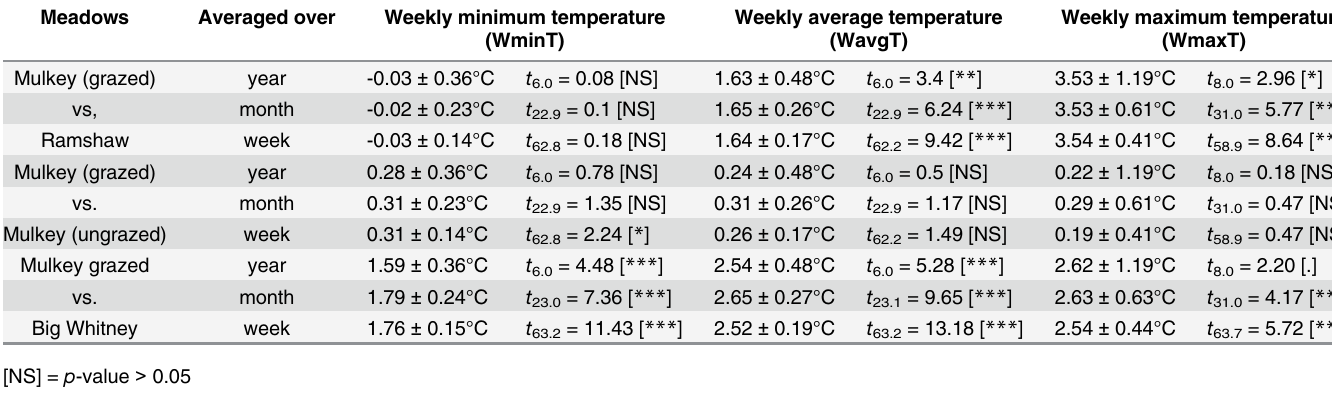
Table 3. Temperature